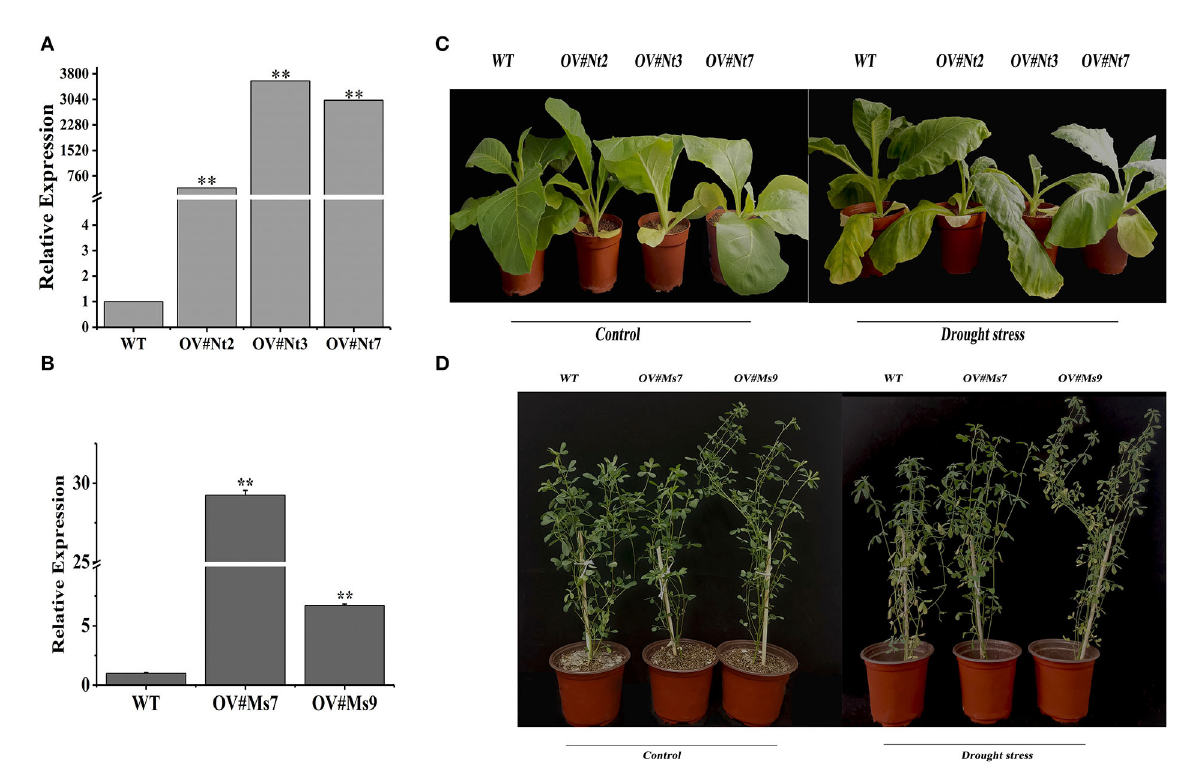
FIGURE3 Identification of transformation with MsTHI1 via qPCR and phenotype of transformation with MsTHI1 under control conditions and drought stress. (A) Identifying transgenic tobacco via quantitative real-time PCR (qPCR). (B) Identifying transgenic alfalfa via qPCR. (C) Phenotype of three-week-old transgenic tobacco plants with overexpressed MsTHI1 under control and drought stress for seven days. (D) Phenotype of six-week-old transgenic alfalfa plants with overexpressed MsTHI1 under control and drought stress for seven days. NtActin and alfalfa GAPDH gene were used as the internal reference control for identifying transgenic tobacco and alfalfa, respectively, via qPCR. Mean ± standard deviations from three biological replicates are shown with error bars. “**”: extremely significant difference between WT and transformation line ( P < 0.01). WT: wild type; OV#Nt2, OV#Nt3, and OV#Nt7: transgenic tobacco lines 2, 3, and 7, respectively. OV#Ms7 and OV#Ms9: transgenic alfalfa lines 7 and 9,